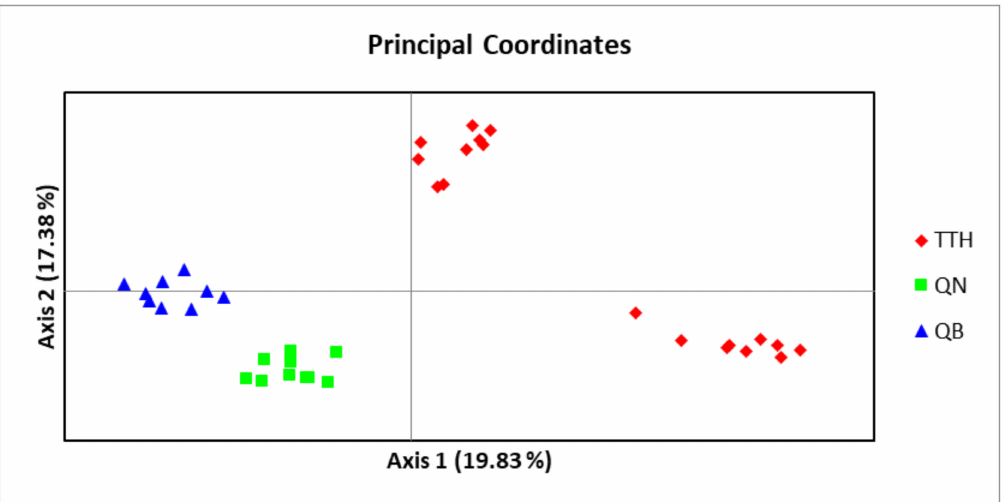
Figure 6. Principal coordinate analysis (PCoA) based on codominant genotypic distance for 37 studied samples of three populations of M. officinalis ( TTH: TTH population; QN: QN population; QB: QB